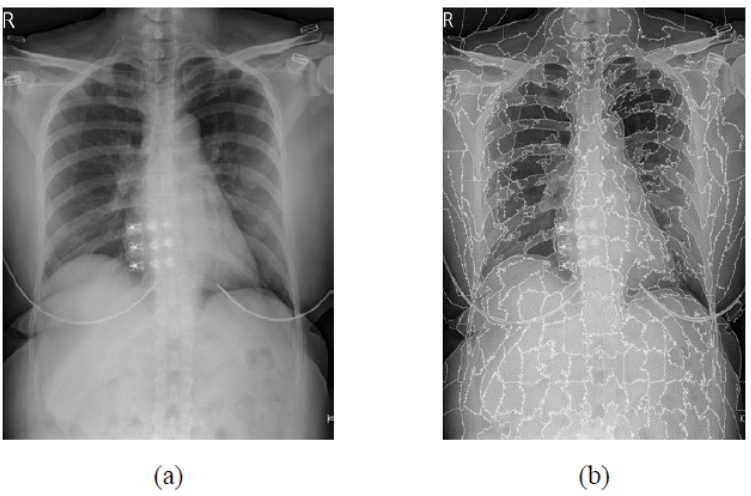
Figure 6. USEQ superpixel extraction result. ( a ) Input image. ( b ) Superpixel results.